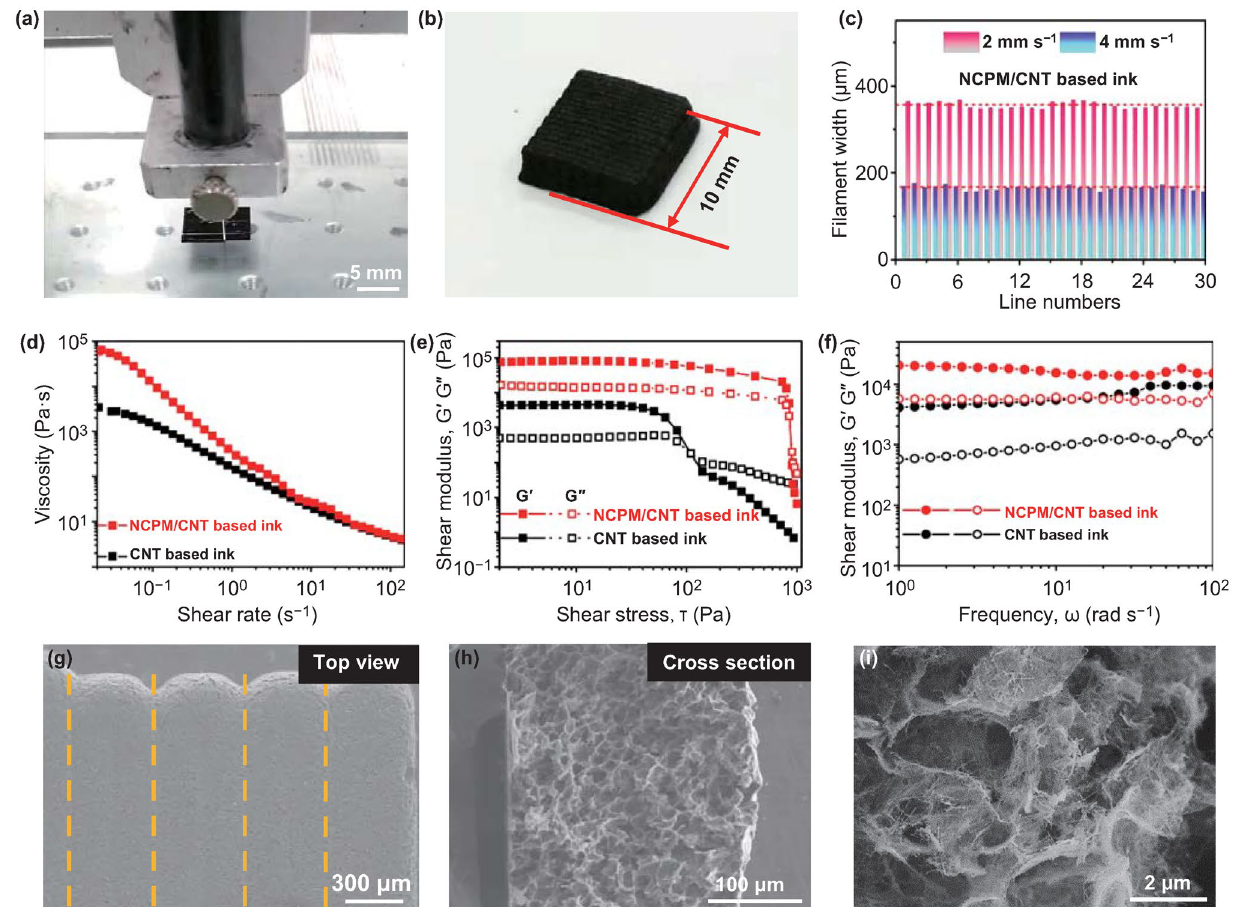
Fig. 3 a Photograph of the 3D printing setup. b Photograph showing the 3D-printed square lattice. c Width distributions of printed filaments by adopting two different printing speeds. d Apparent viscosity of as-fabricated NCPM/CNT and CNT inks as a function of shear rate. Storage modulus (G ′ ) and loss modulus (G ″ ) of NCPM/CNT and CNT inks as a function of e shear stress and f angle frequency. g Top-view and h cross- section SEM images of the printed NCPM electrode. i SEM image displaying the microstructure of the NCPM electrode after